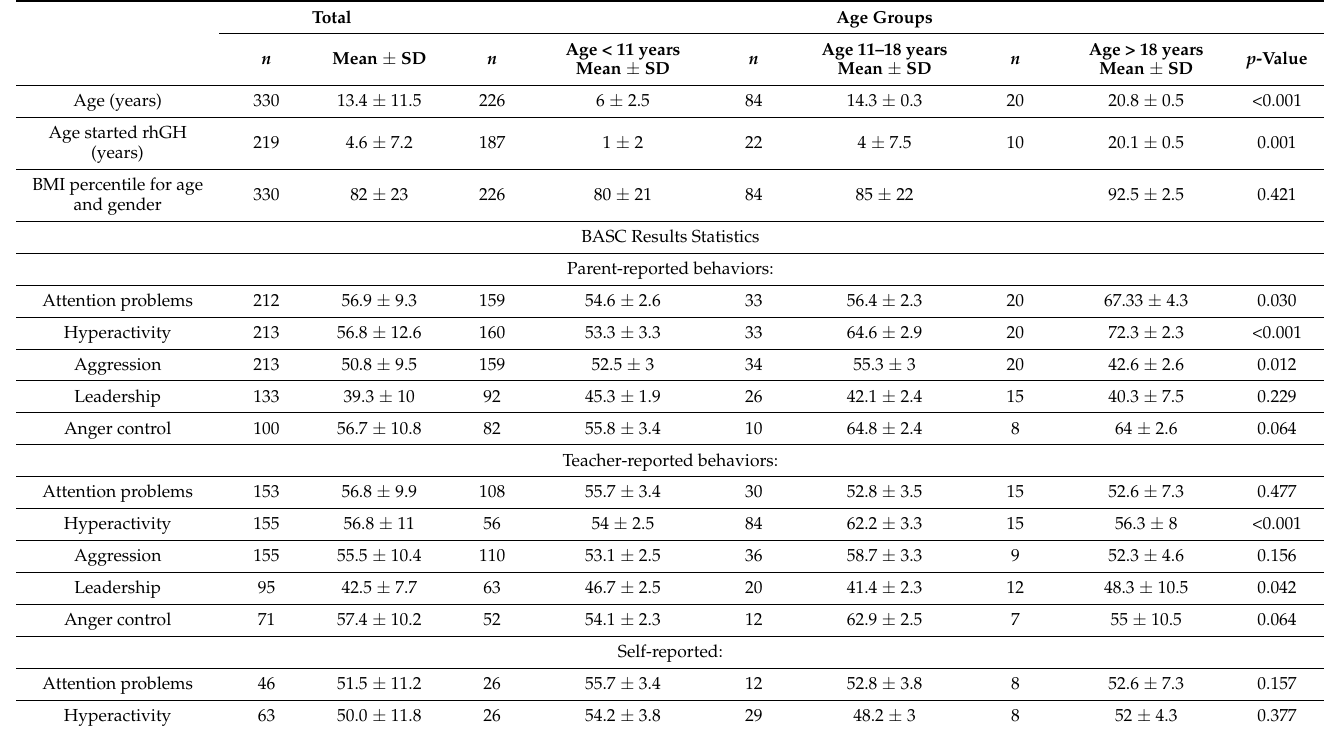
Table 1. Physical characteristics and behavior assessment scores using BASC in 330 genetically confirmed patients with